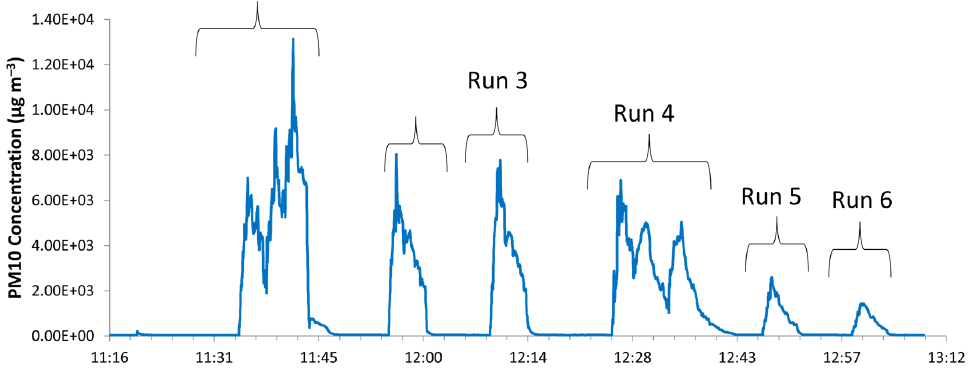
Figure 5. Temporal trend of PM10 concentrations by means of OPC SPS30.